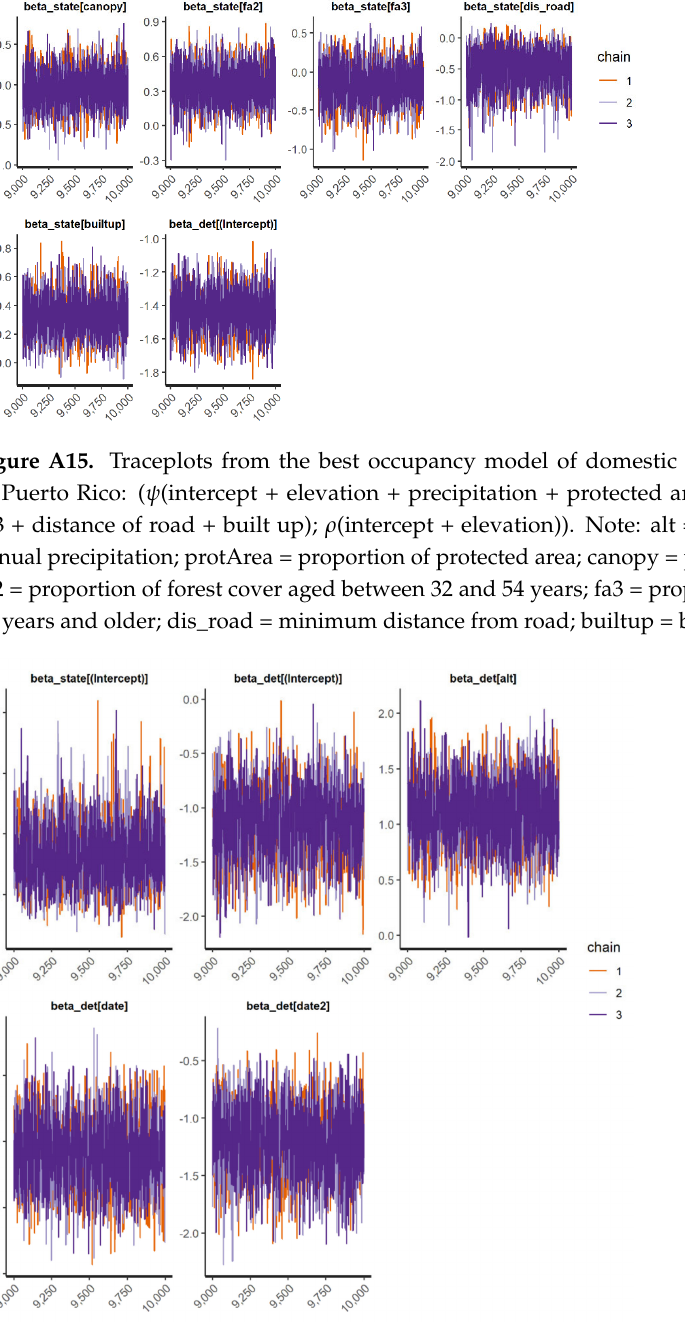
Figure A16. Traceplots from the best occupancy model of wild goat ( Capra hircus ) in Puerto Rico: ( ψ (intercept); ρ (intercept + elevation + date + date2)). Note: alt = elevation; date = Julian date (we considered Julian day 1 as the first day of a device starting to record in the field, which was 1 March 2021); date2 = square of Julian